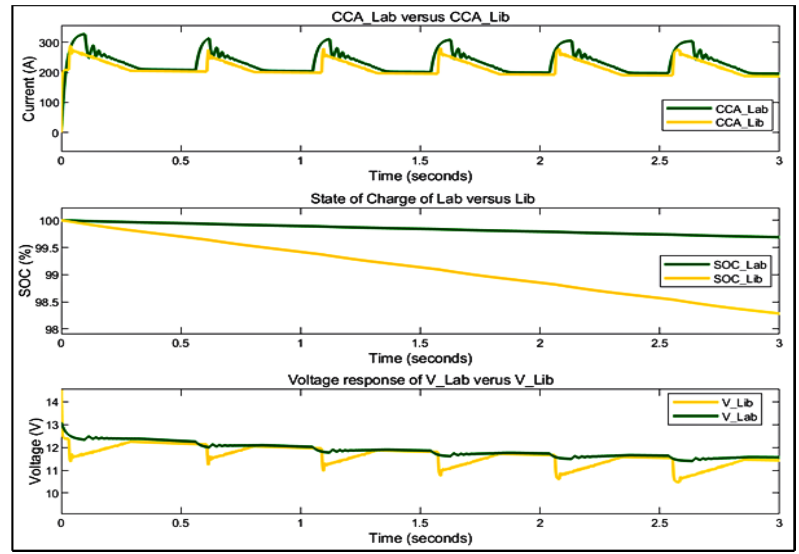
Figure 10. LAB and LIB contribution to CCC, SoC and voltage response during discharge for case two (a).